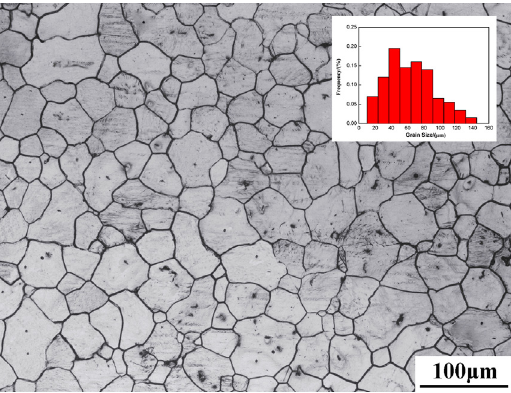
Figure 7. OM and grain size distribution images of alloys homogenized at 380 ºC × 12 h.